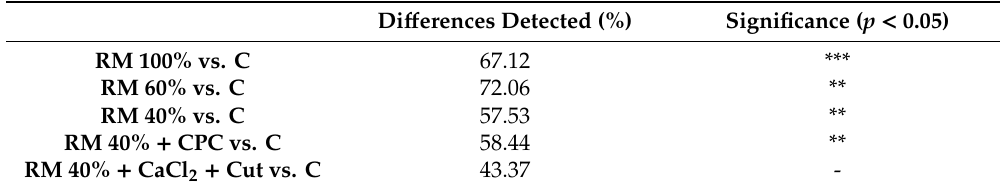
Table 6. Sensory analysis obtained from the triangle tests comparing recombined Crescenza-type cheeses (RM) with the control cheese